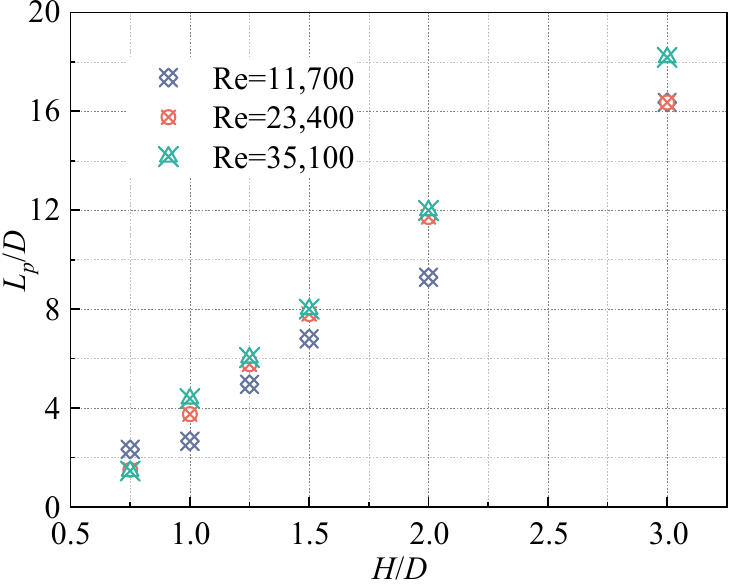
Figure 15. The plot of dimensionless distance L p / D with H / D . Figure 16 depicts the distribution of V / V b at different values of z in the near-wall region in the parameter range of 0 ≤ z / D ≤ 0.5. When H / D = 0.5, the jet structure is a typical wall jet. The values of V / V b decrease gradually with the increase in the jet range. At H / D = 0.75, the distribution of V / V b shows different trends for different z values. At h / D = 0.1 and 0.2, the values of V / V b increase gradually as x increases in the region of 0 ≤ x / D ≤ 10 due to the entrainment effect of the jet, and thereafter, the values of V / V b decrease gradually. The velocity gradient when the jet decelerates is smaller than that when the flow is accelerated. As for increasing h / D , the values of V / V b decrease gradually with the increase in the jet range, and is especially noted that when h / D = 0.3; a velocity smoothing zone appears near the outlet by the influence of the boundary layer of the main stream of the jet. In the zone, the values of V / V b fluctuate around 0.72. When the H / D ranges from1.25 to 2, the velocity in the near-wall area shows a trend of gradual acceleration from 0. After that, a slow deceleration can be found. At the same time, V / V b gradually approaches 0.2 as the hori- zontal height increases. In addition, the acceleration zone near the wall gradually ex- pands.